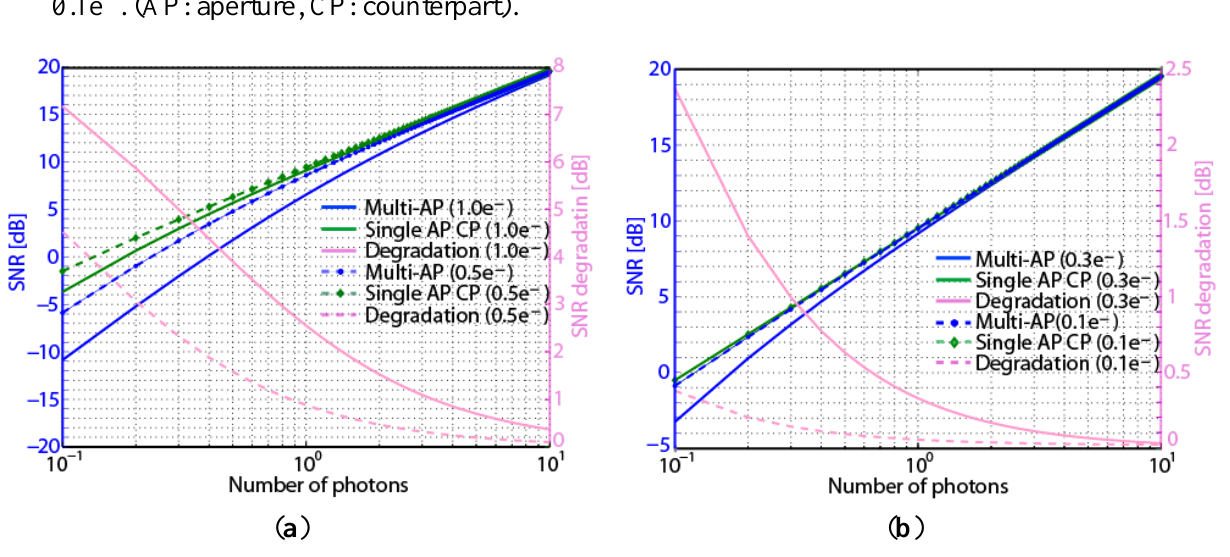
Figure 5. SNRs for different values of amplifier noise. ( a ) 1.0e ⁻ and 0.5e ⁻ . ( b ) 0.3e ⁻ and 0.1e ⁻ . (AP: aperture, CP: